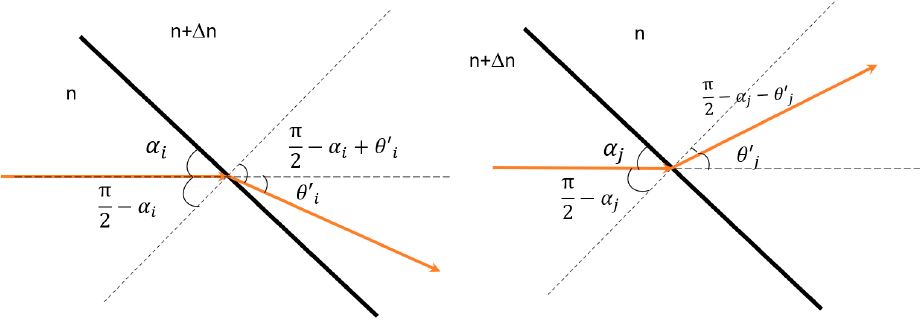
Figure 13. The refraction of the light at interfaces.